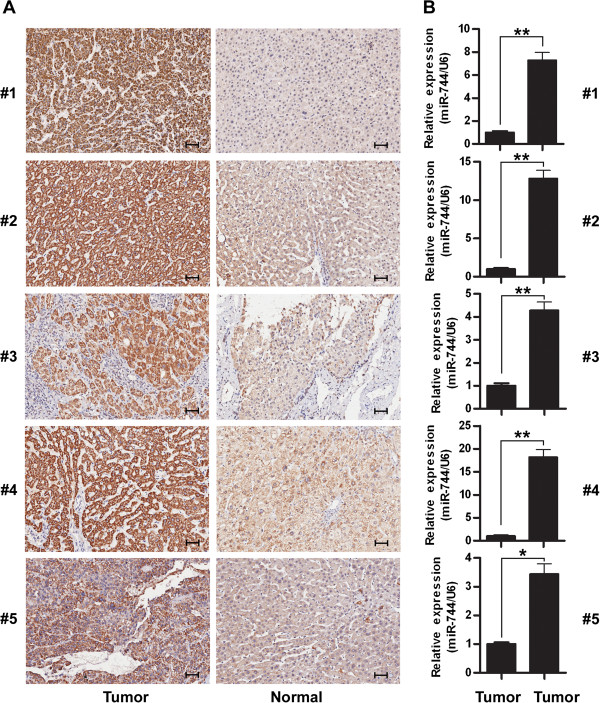
Expression analyses of miR-744 and c-Myc in HCC tissues. (A) Analysis of c-Myc expression in five HCC tissues and adjacent normal tissues by IHC. Brown signal in IHC was considered as positive staining for c-Myc. Scale bar = 50 μm. (B) Analysis of miR-744 expression in the same HCC tissues and adjacent normal tissues by qRT-PCR. The data were subjected to Student's t-test. *p < 0.05, **p < 0.01.